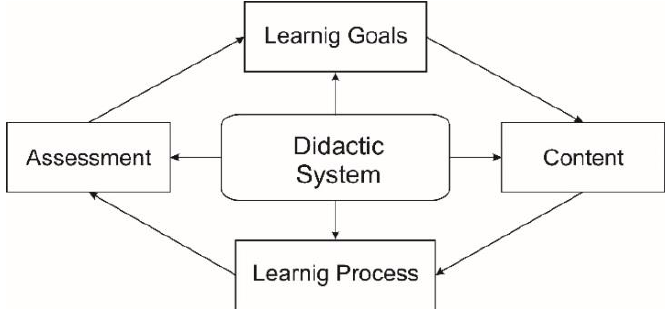
Fig. 1. The structure of the didactic